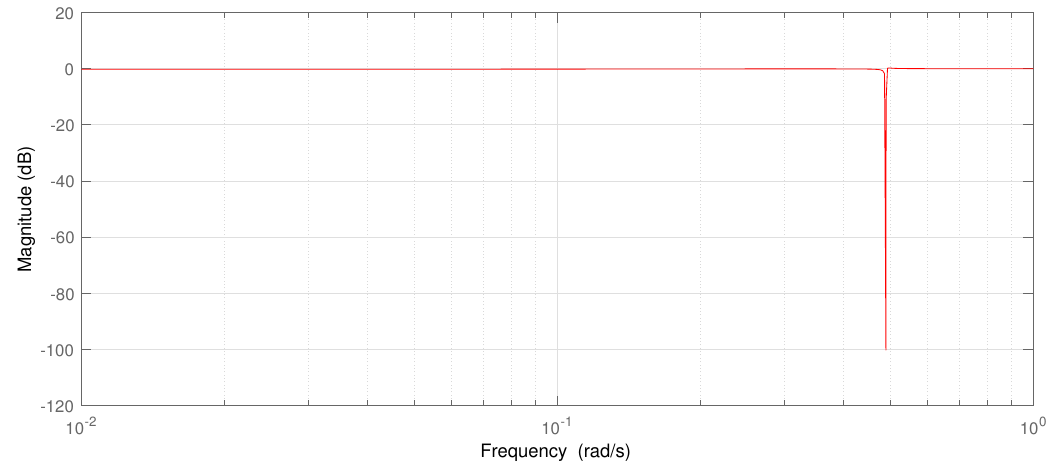
Figure 10. Controller sensitivity for G 1 ( s ) G 2 ( s ) for single wake